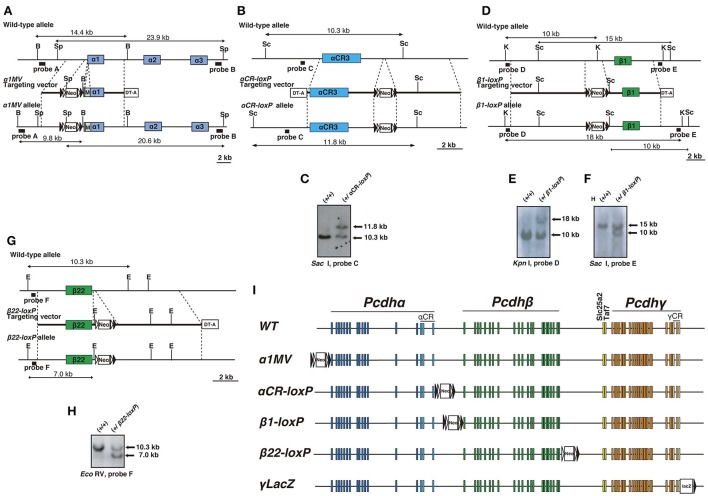
Generation of mice with loxP-site insertions. (A) Generation of α1MV mutant mice. Diagram of the α1MV targeting constructs. M: Myc-tagged-Venus fluorescent protein gene. B: BamHI; Sp, SpeI. (B,C) Generation of αCR-loxP mutant mice. (B) Diagram showing the αCR-loxP targeting constructs. Sc: Sac I. (C) Southern blot of homologous recombinant ES cells digested by Sac I, with Probe C. (D–F) Generation of β1-loxP mutant mice. (D) Diagram showing the β1-loxP targeting constructs. K: Kpn I; Sc: Sac I. Southern blots of homologous recombinant ES cells (E) digested by Kpn I, with Probe D or (F) digested by Sac I, with Probe E. (G,H) Generation of β22-loxP mutant mice. (G) Diagram showing the β22-loxP targeting constructs. E: EcoRV. (H) Southern blot of homologous recombinant ES cells digested by EcoRV with Probe F. (I) Genetic structures of mice with loxP-site insertions. The loxP sites were inserted into the following regions: 5′of the Pcdhα cluster in α1MV mice, 3′ of the Pcdhα cluster in αCR-loxP mice, 5′ of the Pcdhβ cluster in β1-loxP mice, 3′ of the Pcdh β cluster in β22-loxP mice, and 3′ of the Pcdhγ cluster in γLacZ mice. Filled and open triangles represent loxP and frt sites, respectively.